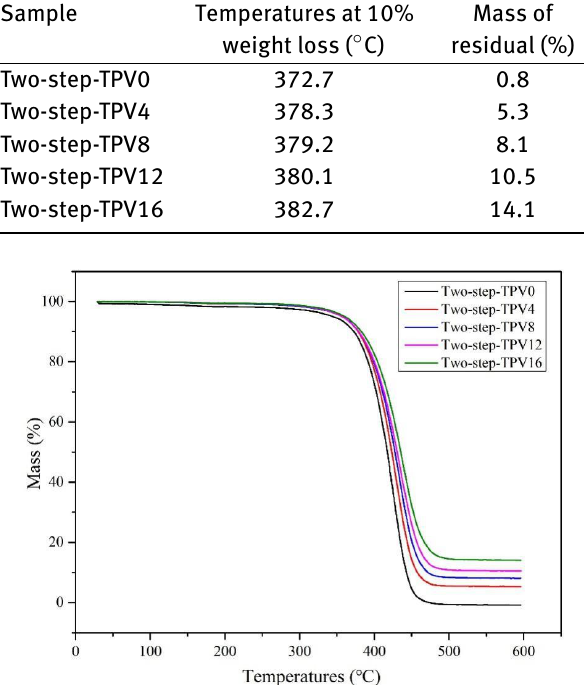
Figure 5: TGA curves of two-step-TPV with different content of